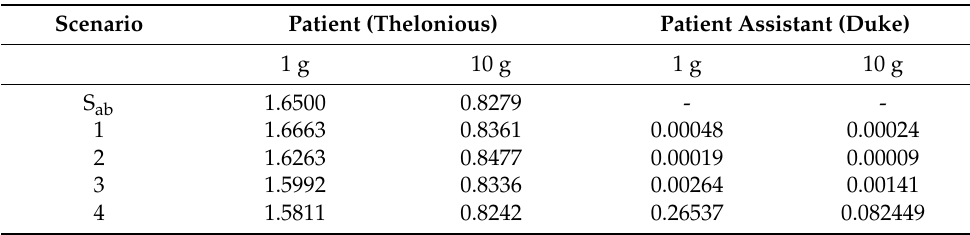
Table 3. Peak spatially averaged SAR (W/kg) in Thelonious (patient) and Duke (patient assistant) according to head RF coil (input power = 1